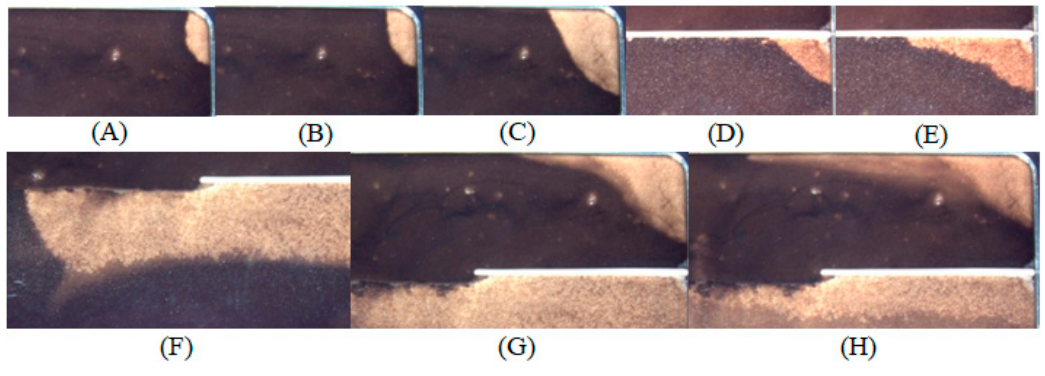
Figure 10. Migration diagram of oil–gas interface.